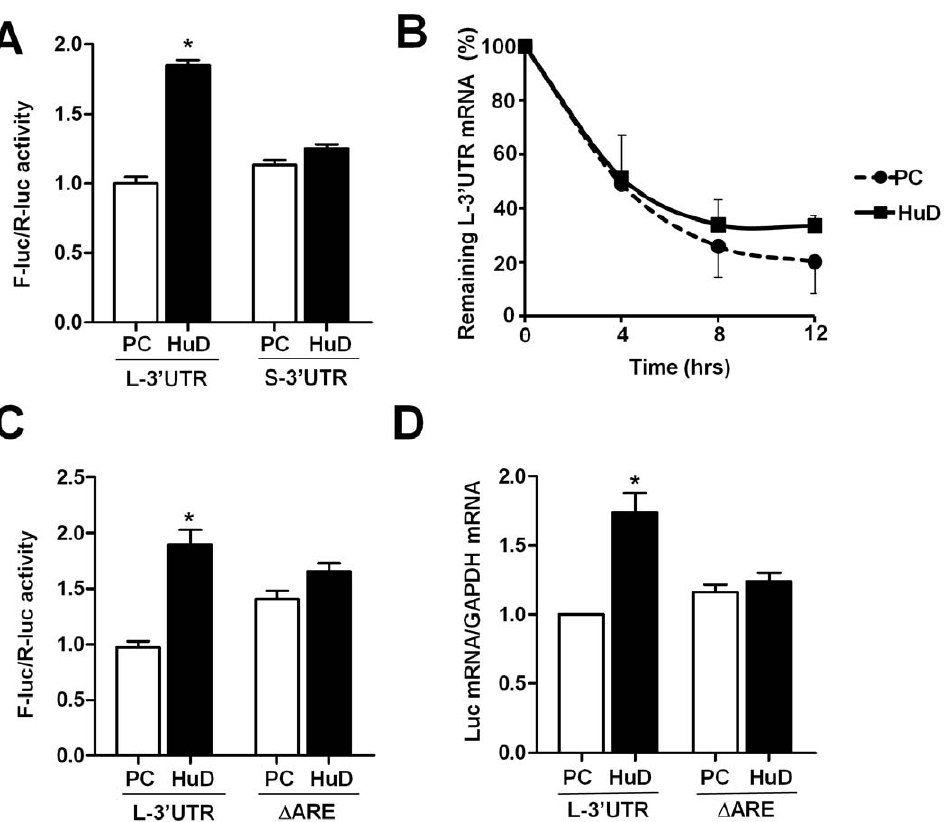
Figure 2. HuD selectively enhances expression of the luciferase reporter that harbors the BDNF long 3 9 UTR in an ARE-dependent manner. CAD cells were cotransfected by 200 ng of reporter construct together with either pcDNA-HuD (HuD) or the pcDNA parental vector (PC). 20 ng of pRL-CMV Renilla luciferase construct was included in each transfection. Twenty-four hours after transfection, cells were harvested and subjected to dual luciferase reporter assay or mRNA extraction followed by DNAase-treatment and RT-qPCR. (A) myc-HuD enhances expression of the luciferase reporter that carries the BDNF long 3 9 UTR but not the short 3 9 UTR. (B) myc-HuD reduces decay of the BDNF long 3 9 UTR reporter mRNA in co-transfected CAD cells in which transcription is inhibited by actinomycin D. (C) Loss of the ARE in the BDNF long 3 9 UTR abolished the repose to HuD-dependent enhancement of reporter expression. (D) HuD regulates reporter mRNA expression mediated by the ARE in the BDNF long 3 9 UTR. * indicates P , 0.05 by Student’s t-test